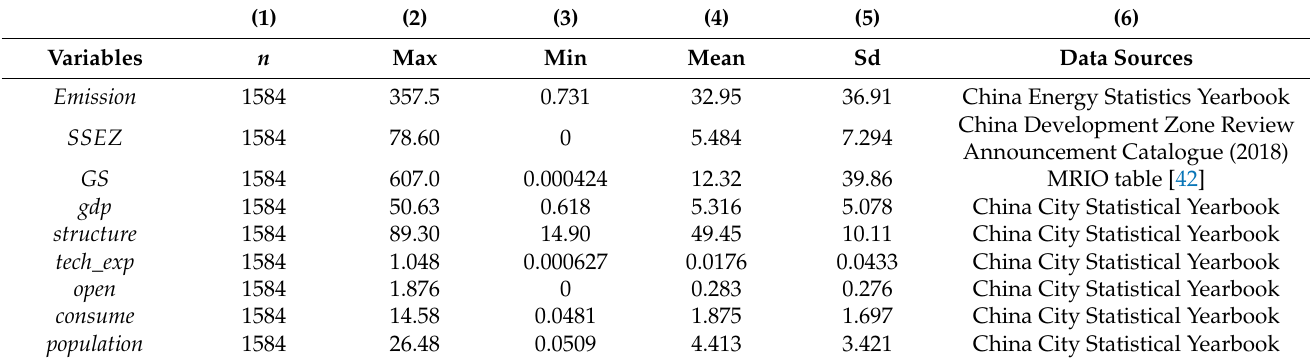
Figure 2. Distribution of two types of ETDZs in 264 prefecture-level cities in China ( left : provincial- level zones; right : national-level zones). Source: Own creation, results of ArcGis (Esri, Redlands, CA, USA). Table 1. Descriptive statistics and data